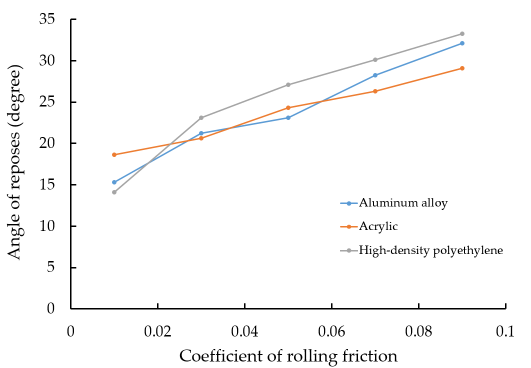
Figure 10. Effect of the coefficient of rolling friction between rapeseed particles and different materials on the angle of repose.